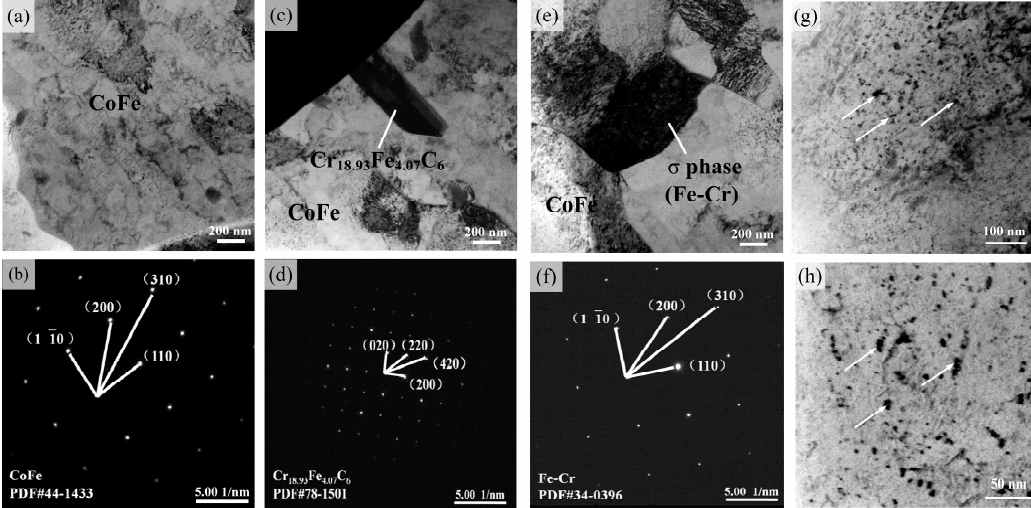
Figure 7. TEM images ( a , c , e ) and diffraction patterns ( b , d , f ) of the microstructure in light zone of sample #2; TEM bright field images in ( g ) the fusion zone and ( h ) diffusion zone of sample #2.